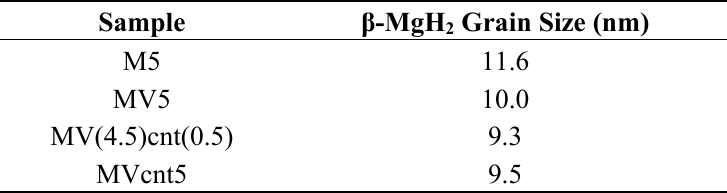
Figure 2. XRD profiles of MgH 2 and MgH 2 -based composites milled for 5 h. Table 1. Grain size of β -MgH 2 in various